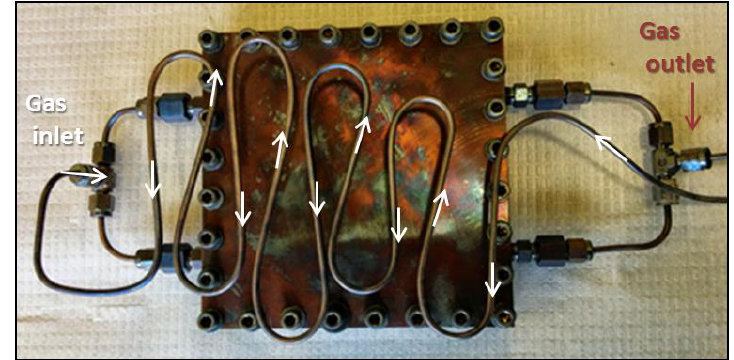
Figure 3. Serpentine used to increase gas residence time inside furnace and, thus, temperature.